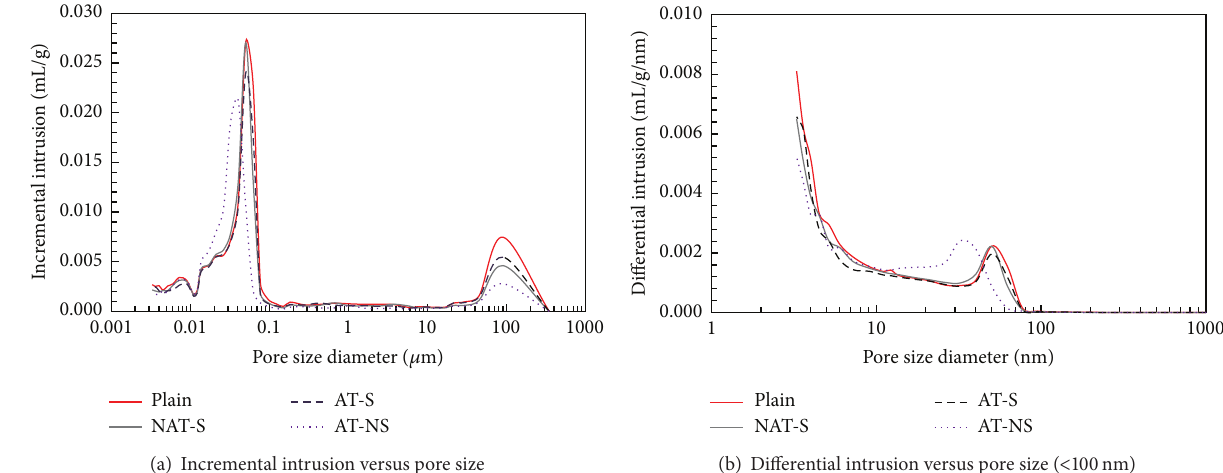
Figure 10: Pore size distribution with different